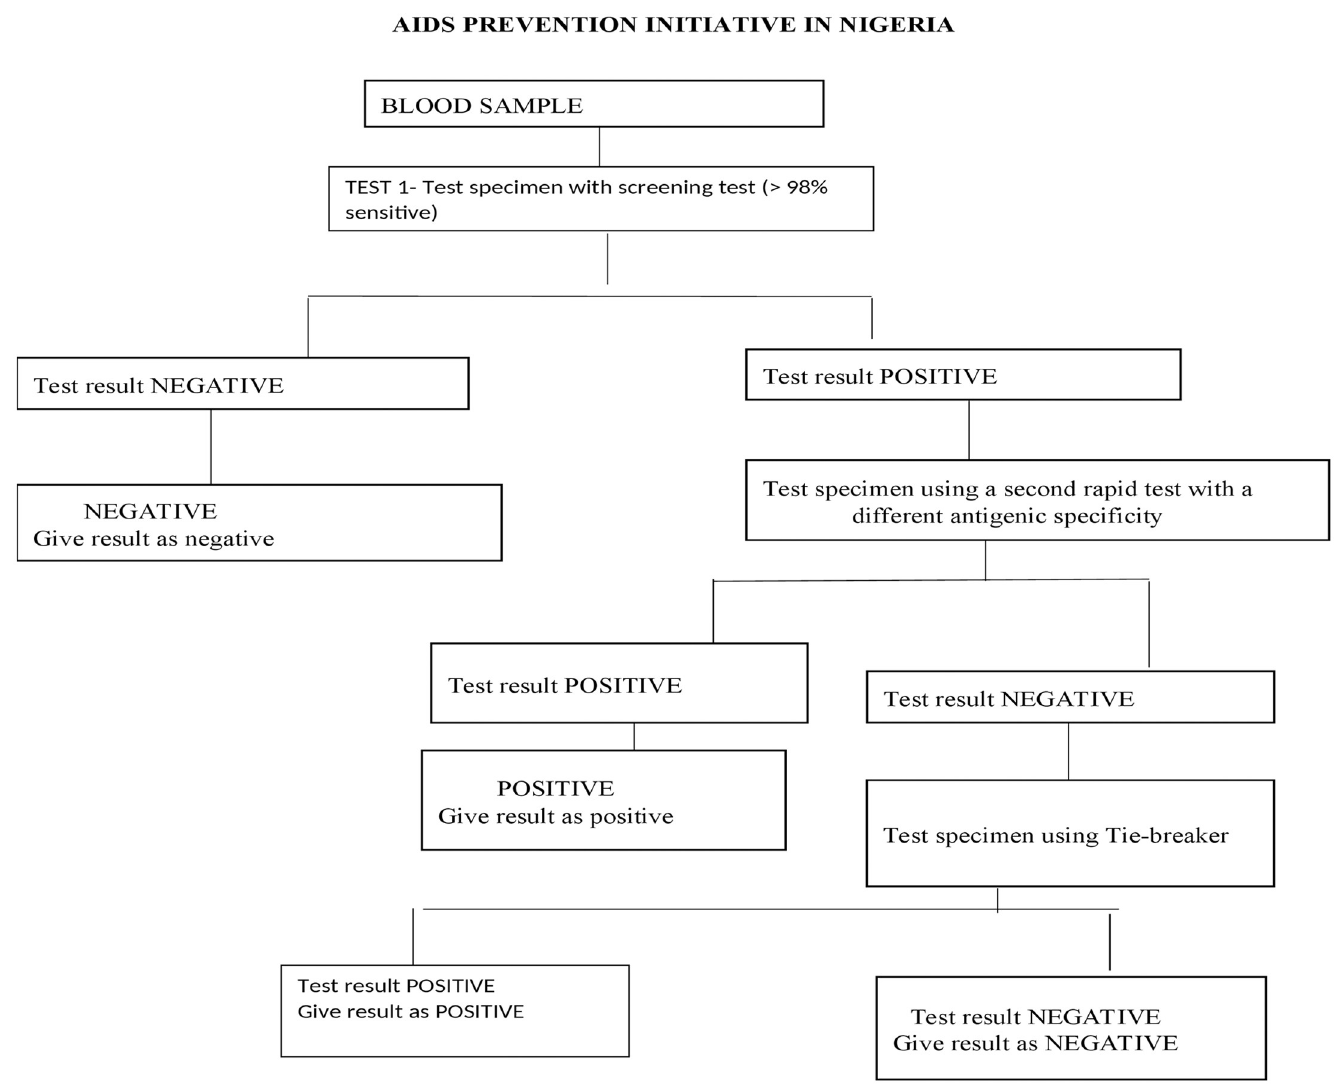
Fig 1. Serial algorithm for rapid HIV testing. [28] SSS These are WHO certified rapid kits use in LUTH. Test 1 (Determine, the sensitivity of 100% and specificity of 99.9%), test 2 (Unigold, the sensitivity of 100% and specificity of 99.9%), and test 3 (statpak which is a tiebreaker with 100% sensitivity and 100% sensitivity).